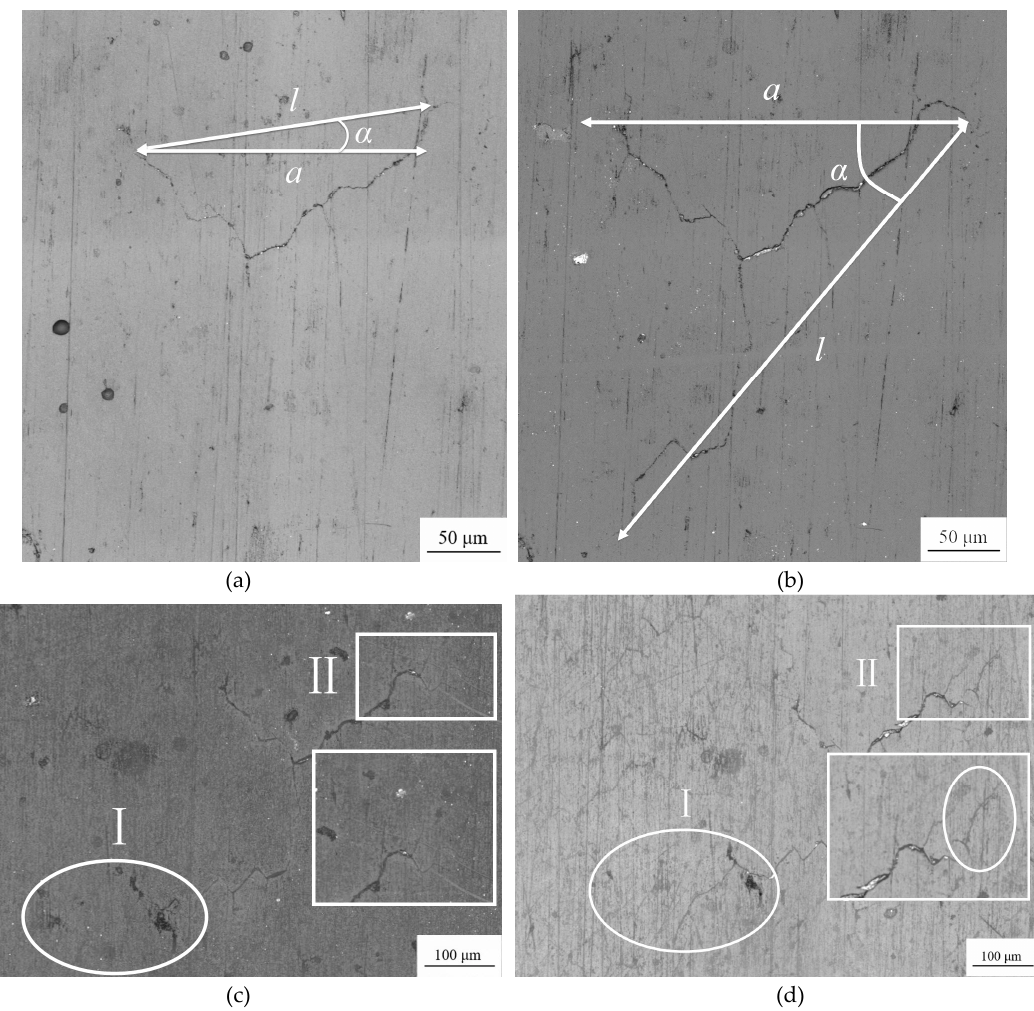
Figure 9. Cracks corresponding to decreases in crack growth rate of specimen TC2: ( a ) N = 3,000 ( f = 0.05); ( b ) N = 7,000 ( f = 0.12); ( c ) N = 16,000 ( f = 0.26); ( d ) N = 20,000 ( f = 0.33).